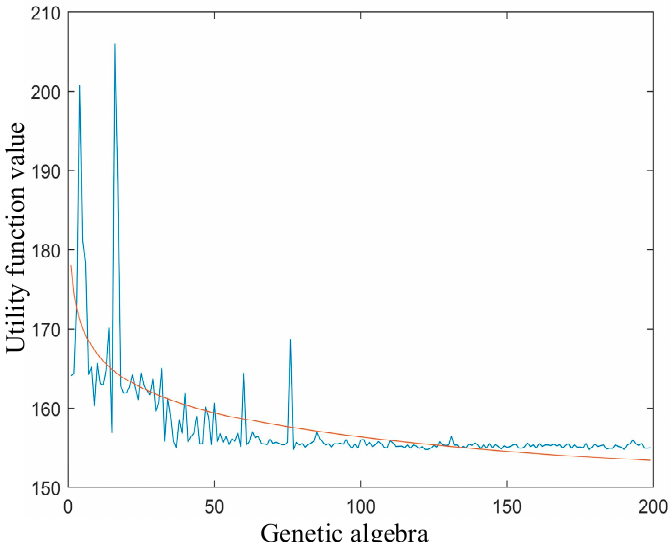
Figure 7. The utility function changes during iteration.